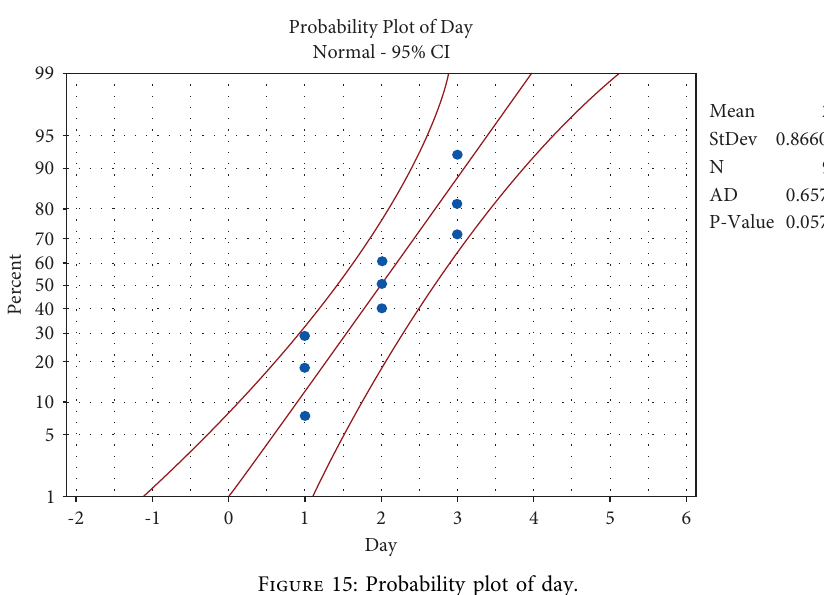
Figure 15: Probability plot of day.